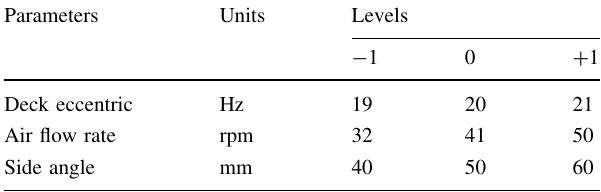
Table 3 Process variables and their